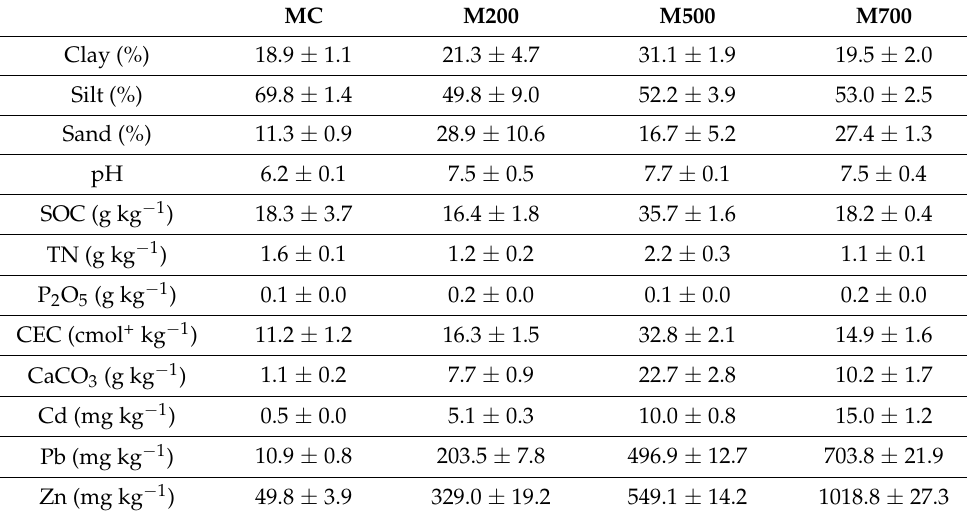
Table 1. Soil physicochemical and trace elements (T.E.) concentrations in the studied plots (MC, M200, M500, M700). Results are presented as mean ± standard error ( n = 6). SOC: soil organic carbon, TN: total nitrogen, P 2 O 5 : available phosphorus, CEC: cationic exchange capacity, CaCO 3 : calcium